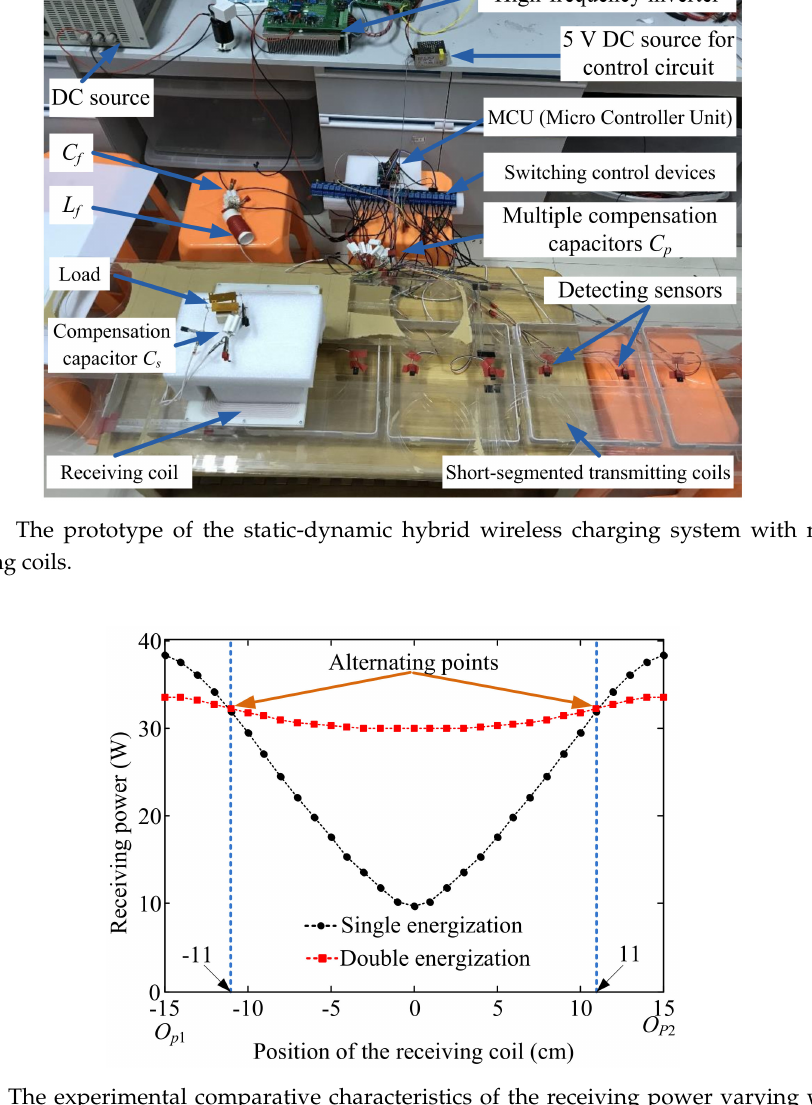
Figure 12. The experimental comparative characteristics of the receiving power varying with the position of the receiving